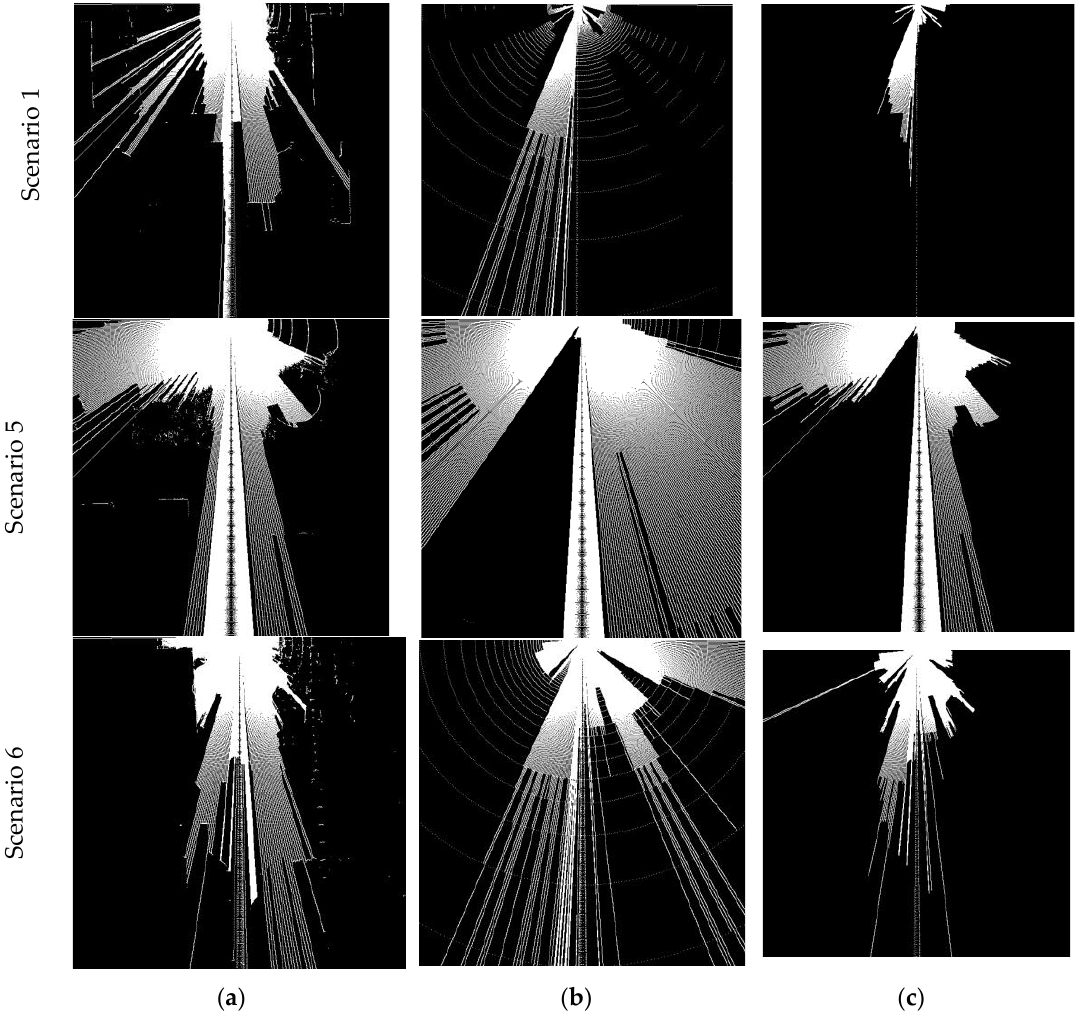
Figure 10. Comparison of free-space maps for different algorithms for three different scenarios. ( a ) LiDAR only; ( b ) Image classifier only; ( c ) Fusion-based approach.